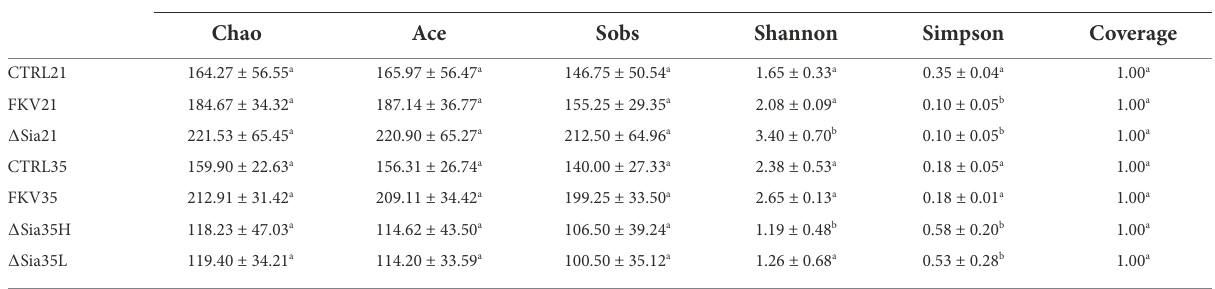
TABLE 2 Alpha diversity indices and difference analysis of the gut microbiota in different groups. Group